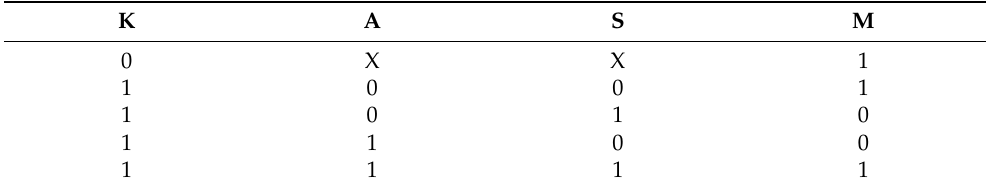
Table 2. Truth table of CAM cell match unit.